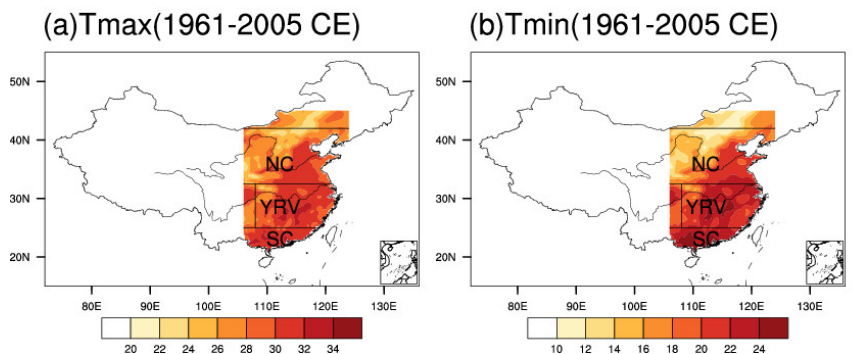
Figure 1. CN05.1 observed summer (June–July–August, JJA) mean Tmax ( a ) and Tmin ( b ) (units: °C) between 1961 and 2005 CE over monsoonal China. Three sub-regions, North China (NC), the Yangtze River Valley (YRV) and South China (SC), are framed. River Valley (YRV) and South China (SC), are